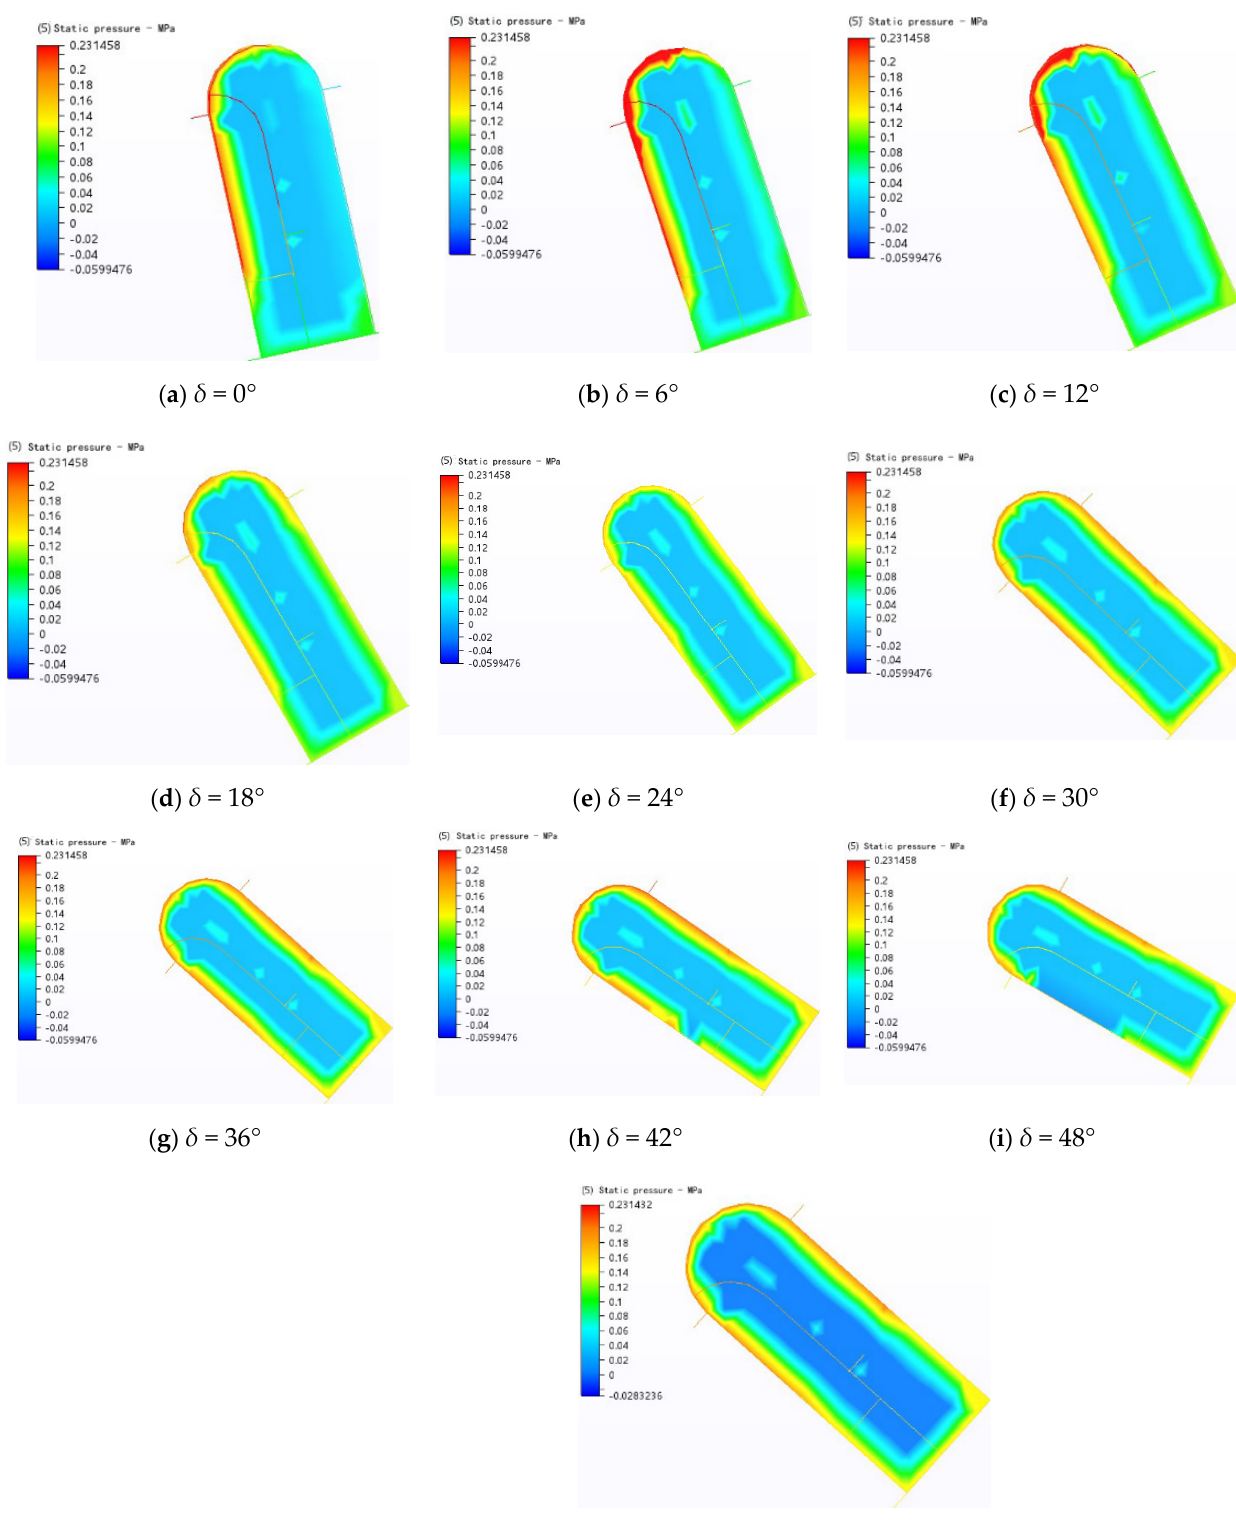
Figure A2. Fluid pressure nephogram under different slide angles.